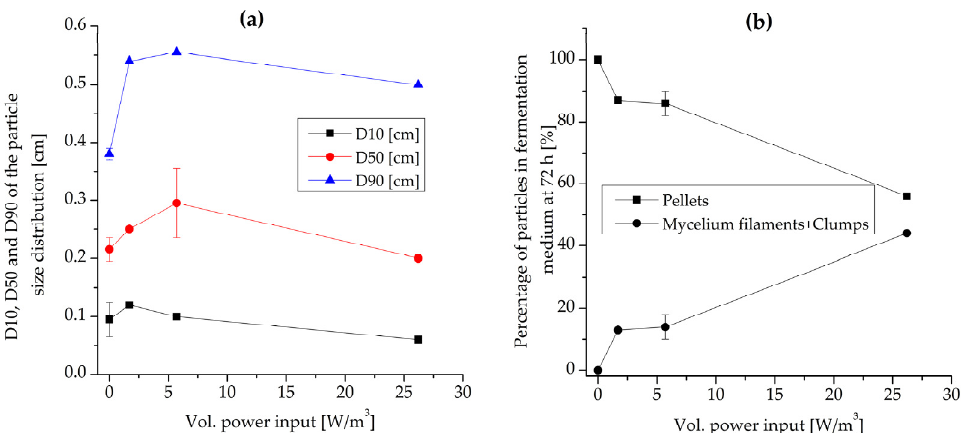
Figure 3. D10, D50, and D90 value of particle size distribution of pre ‐ culture and fermentations at different volumetric power inputs at 72 h ( a ); Percentage of pellets, mycelium filaments and clumps of pre ‐ culture and fermentations at different volumetric power inputs at 72 h ( b ), the points at 0 W/m 3 volumetric power input indicate the parameter values of the pre ‐ culture.